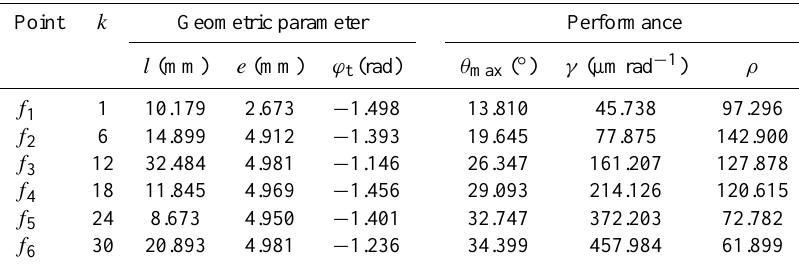
Table 2. The optimal solutions. Point k Geometric parameter Performance l